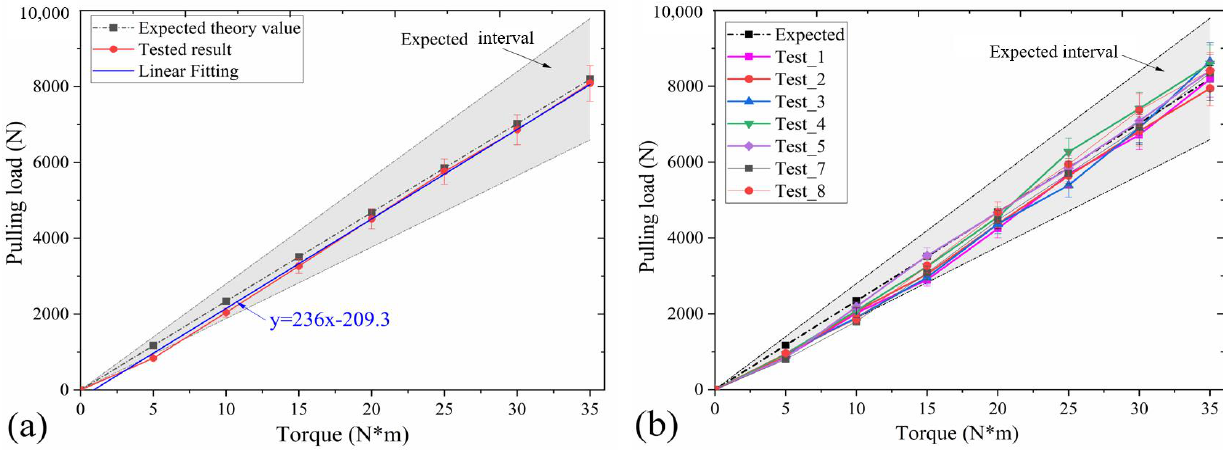
Figure 10. Test results of the applied torque and corresponding bolt tension, ( a ) typical result and linear fitting, ( b ) repeated tests.